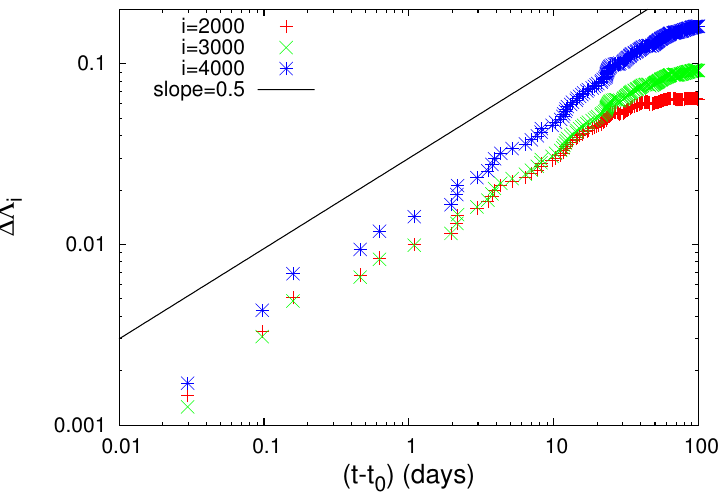
Figure 18. The same as Figure 16, but for the M 7.5 EQ on 15 January 1993 at 42.92 ◦ N 144.35 ◦ E. The t 0 value is 0.014 days measured from the M 7.5 EQ occurrence and c = 0.5. Taken from Ref.